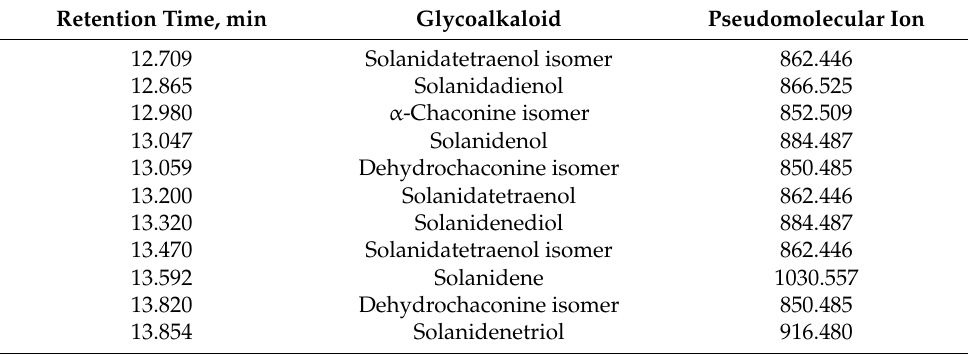
Table 1. Glycoalkaloids identified in potato samples using analytical standards ( α -chaconine and α -solanine) and literature and in silico